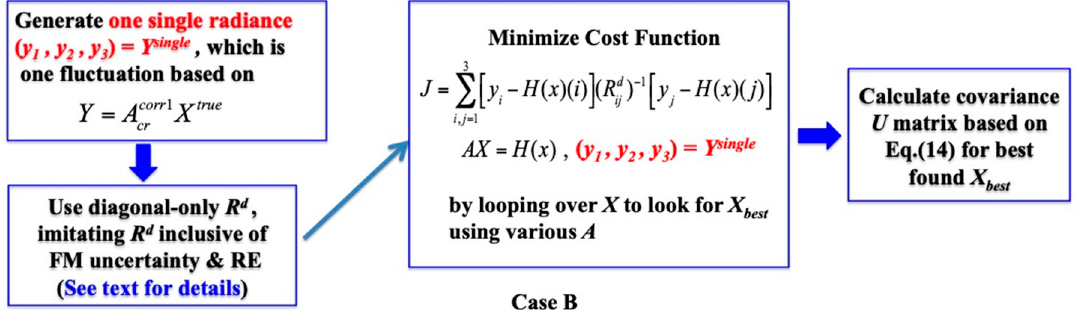
Figure 6. Analysis procedures for Cases B, where FM uncertainty and RE stand for forward model uncertainty and representativeness error, respectively. Table 2. Results for Case B, where 𝑌 (cid:2869)(cid:3046)(cid:3036)(cid:3041)(cid:3034)(cid:3039)(cid:3032) (or 𝑌 (cid:2870)(cid:3046)(cid:3036)(cid:3041)(cid:3034)(cid:3039)(cid:3032) ) means data from single measured radiance, the second column means 𝑅 (cid:3031) matrix is based on what for construction, and the third column represents what 𝐻 ( 𝐴 ) is used in minimization.